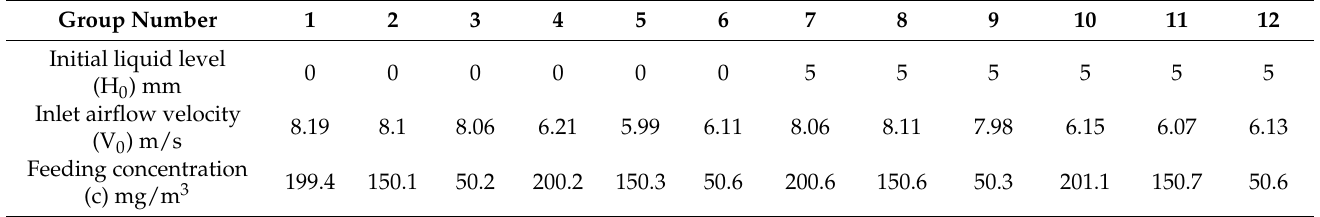
Figure 5. Effect of ( a ) liquid level; ( b ) inlet airflow velocity; ( c ) feeding concentration; and ( d ) dust concentration after purification on wet scrubber efficiency for tobacco dust removal. Table 5. Initial liquid level, inlet airflow velocity, and feeding concentrations selected for the present